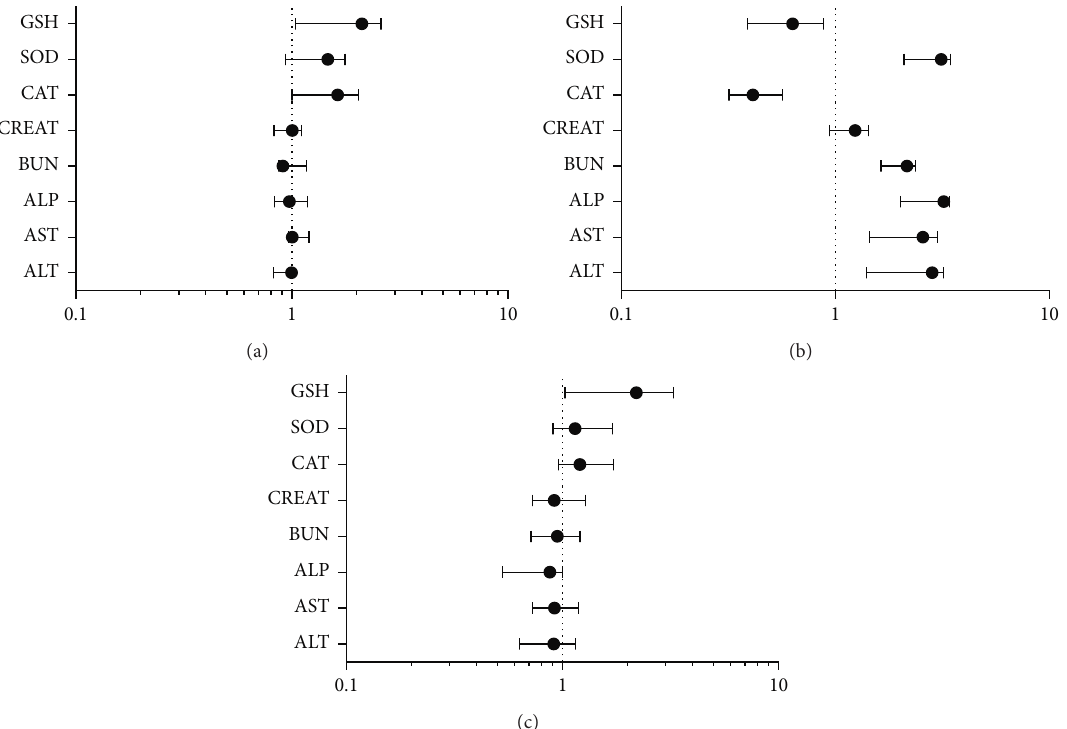
Figure 1: Binomial logistic regression of biochemical parameters as a time function. The model was adjusted for each graph (0, day zero of treatment; 1, after 3 months of treatment). The results are significant if p < 0 . 05. (a) Odds ratio of the decoction group. (b) Odds ratio of the ARV group. (c) Odds ratio of the ART +decoction